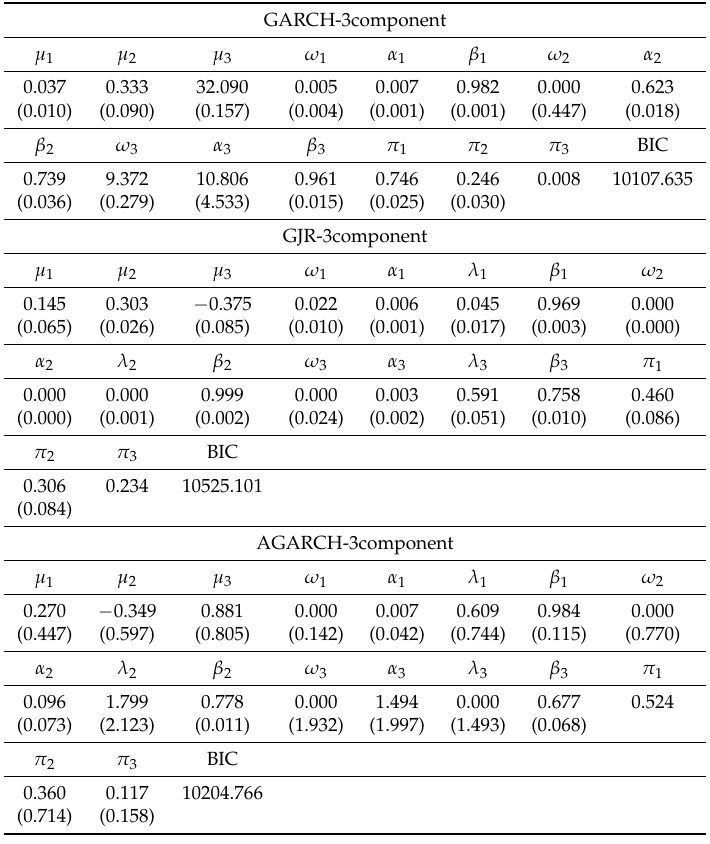
Table 6. Estimation of the Three Classes of GARCH(1,1) Families in